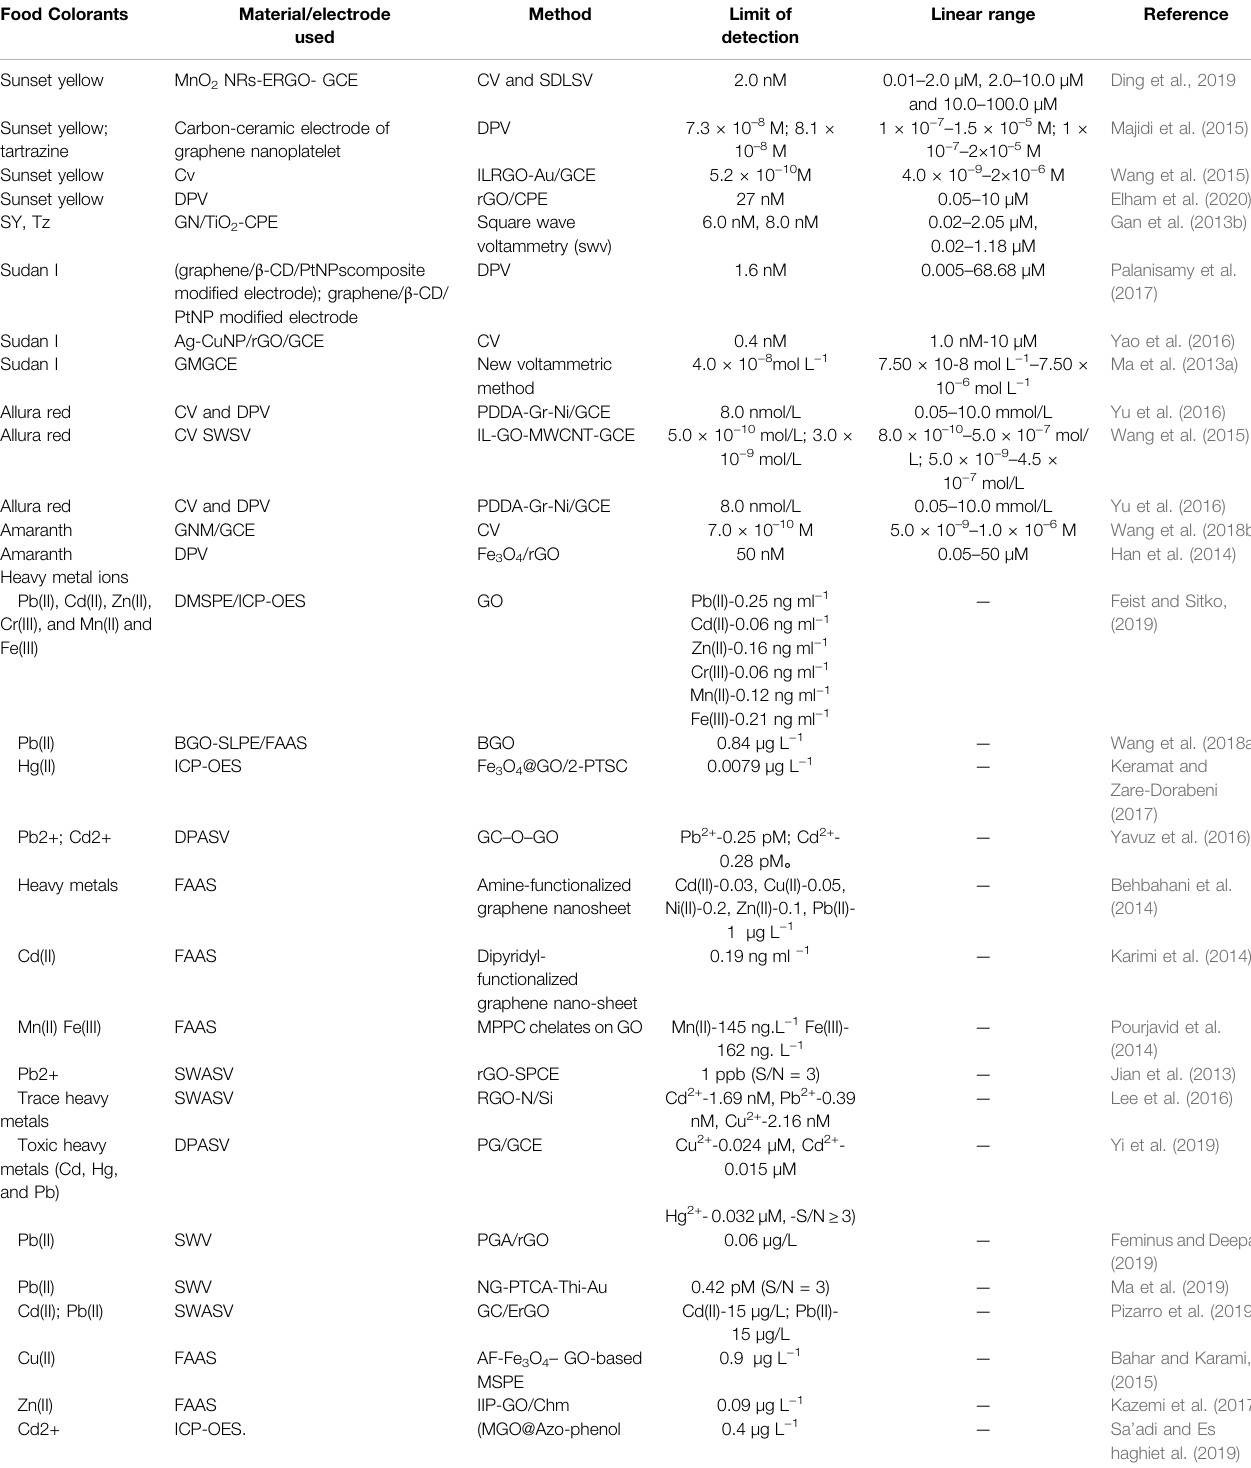
TABLE 1 | Applications of graphene in detecting pigments and heavy metal